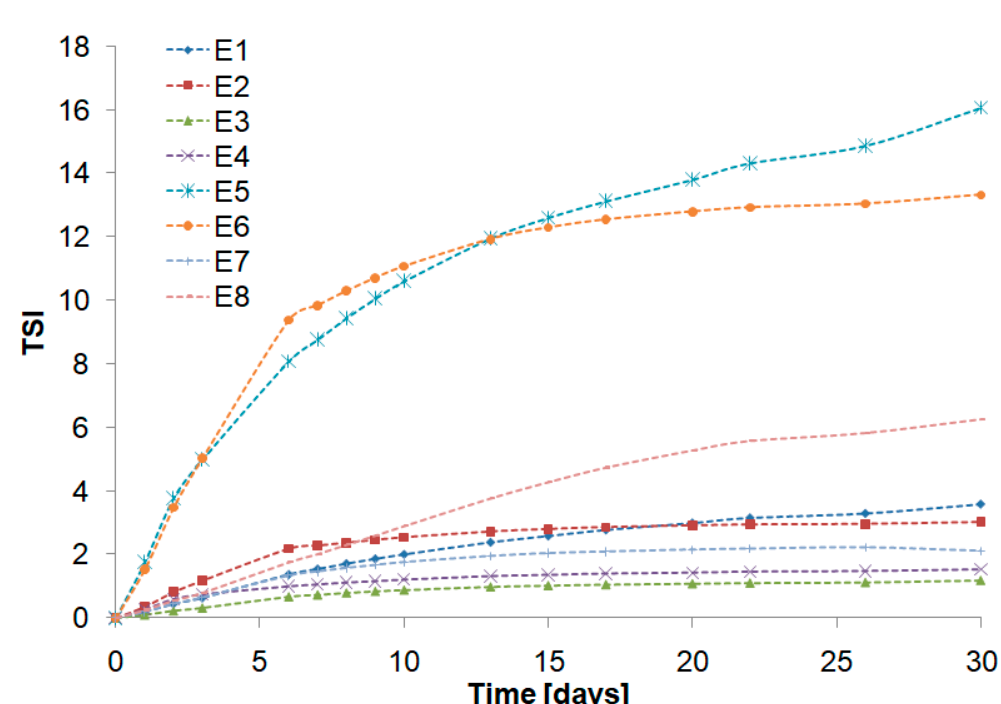
Biomolecules 2020 , 10 , x FOR PEER REVIEW Figure 5. Turbiscan stability index (TSI) variation for the prepared emulsions.